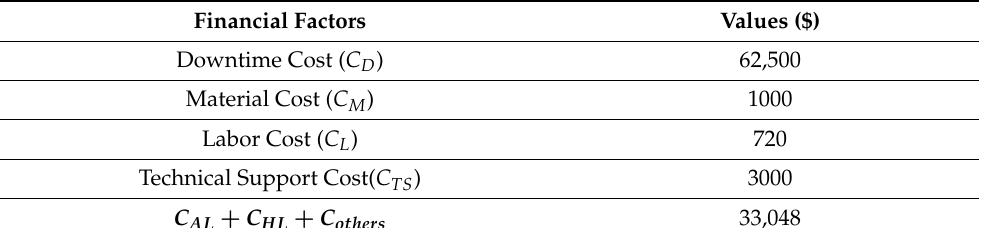
Table 7. Financial factors and their values updated by bearing-related fault in the compressor.